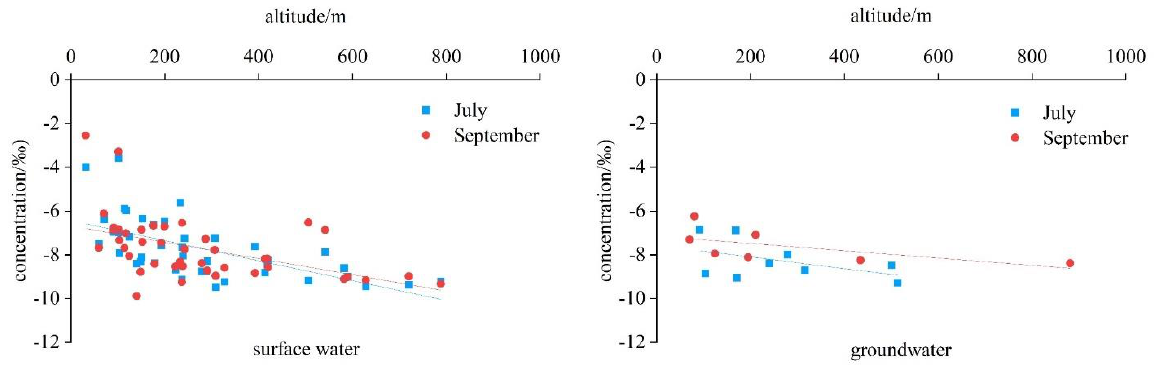
Figure 7. Average concentrations of main cations and anions in the surface water of the mountain- ous watershed of Daqing River (CH—Ci river, SH—Sha river, TH—Tang river, CH2—Cao river, ZY—Zhongyi river, JM—Juma river). 5.2. Correlation between Isotopic Composition and Hydrochemical D and 18 O in water are stable isotopes that make up the water molecule. When the water body's hydrogen and oxygen isotopic composition is not significantly correlated with the ion mass concentration and mineralization, the water is mainly affected by the